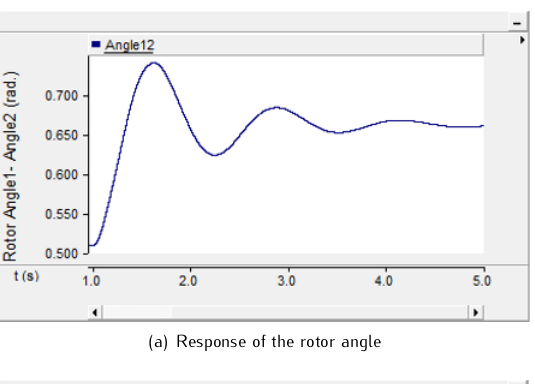
Figure 2 400MW increase of power transfer under PSS control